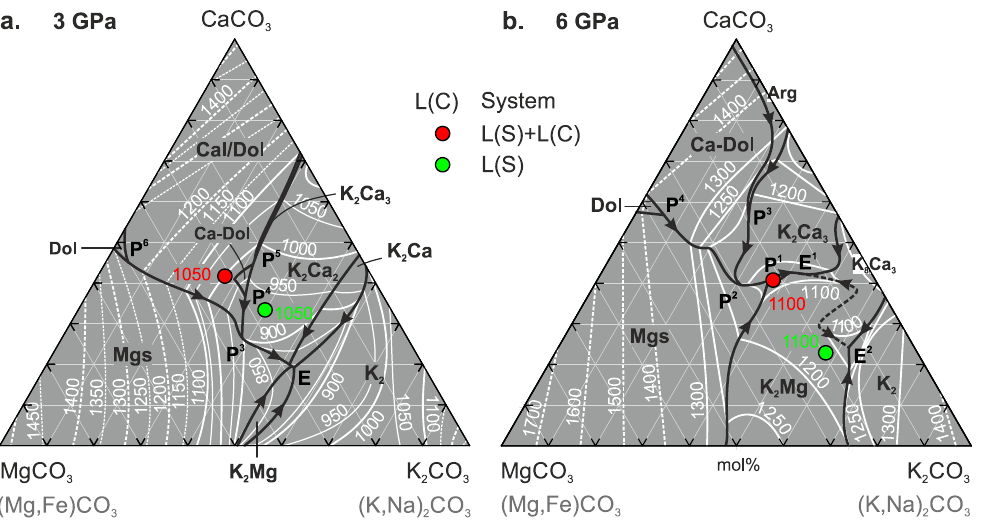
Figure 18. Carbonate melt compositions plotted on the liquidus projections of the K 2 CO 3 -MgCO 3 - CaCO 3 system at 3 GPa [74] ( a ) and 6 GPa [73] ( b ).